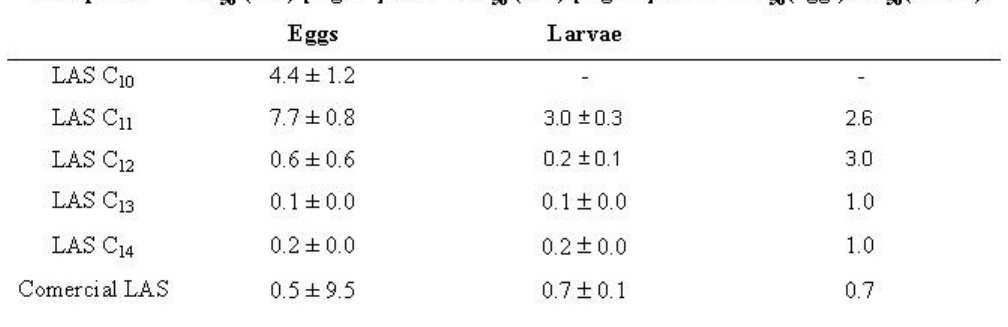
LC Values and Standard Deviation after 24 h of Exposure to Different LAS Homologues 50 and Commercial LAS for Seabream Eggs and Larvae, As Well As Ratio between LC (Eggs) and LC 50